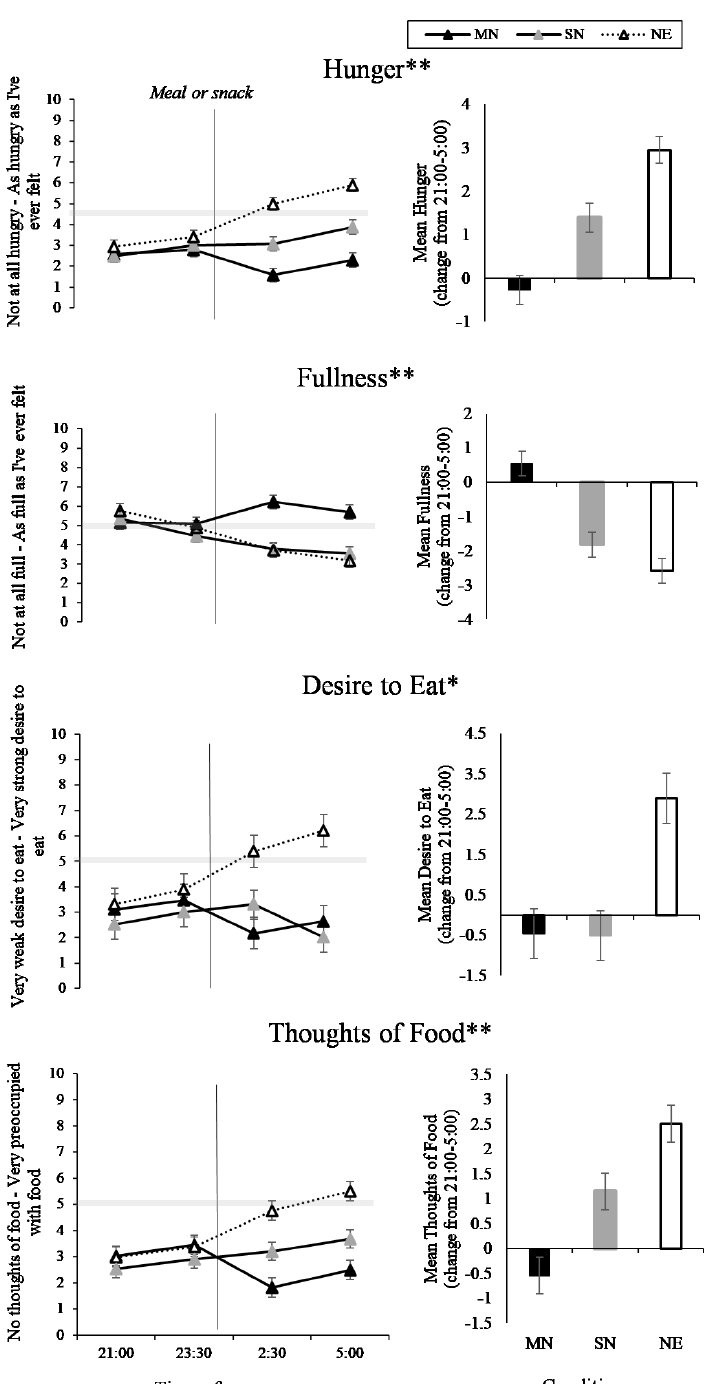
Figure 4. Food and hunger Visual Analogue Scales (VAS) results from the interaction e ff ect between eating condition and time of night (line graphs), and the total mean change from 21:00 to 5:00 (bar graphs). Black lines with black markers and the black columns represent the Meal at Night condition (MN), black lines with grey markers and the grey columns represent the Snack at Night condition (SN), dashed lines with white markers and the white columns indicate the No Eating at Night condition (NE). The vertical black line on each line graph indicates when the meal or snack was consumed. The grey shaded horizontal line on each line graph indicates the midpoint of each VAS. Means presented are estimated marginal means, and error bars indicate standard errors from model estimates. Asterisks indicate a significant interaction e ff ect (* p < 0.05, ** p <